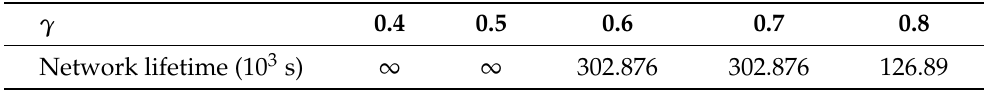
Table 9. The impact of γ on the network